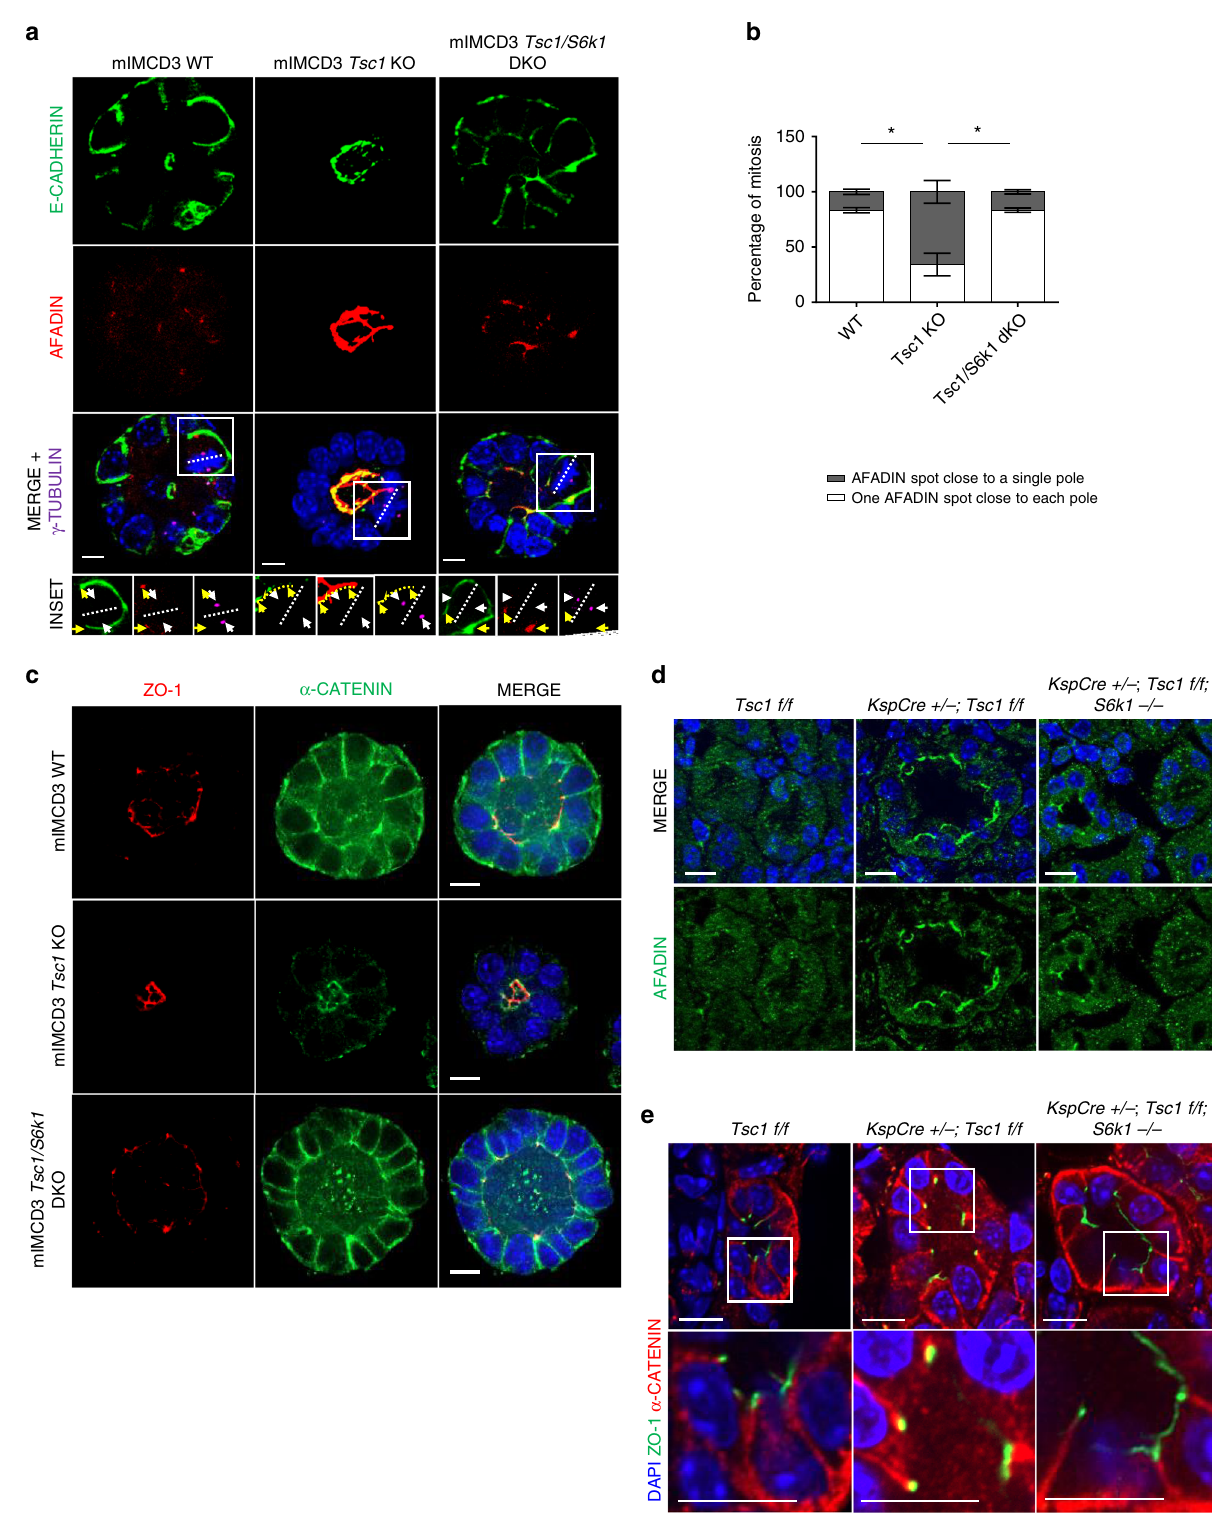
throughout the whole apical domain (Fig. 9a and Supplementary Fig. 12a). During mitosis of wild type and Tsc1/S6k1 -mutant cells, the two Afadin spots at the AJs were found at opposite sides of the spindle equator, each one close to one spindle pole (Fig. 9a, b). However, in the majority of Tsc1 mutant cells, the Afadin spots were on the same side of the spindle equator, close to a single pole, and in other mitotic events, it was impossible to